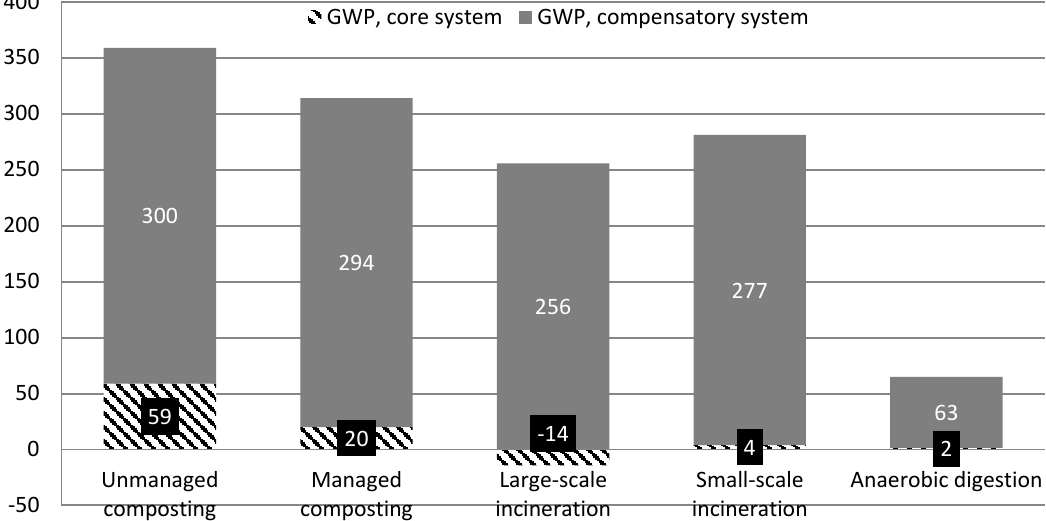
Figure 3. Global warming potential (GWP) in simulated scenarios. eq.: equivalents.